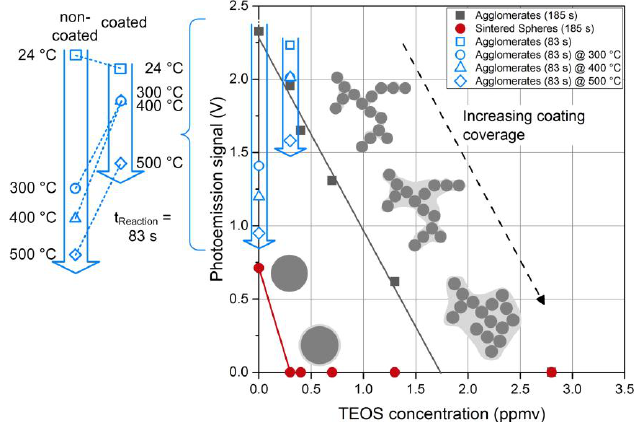
Figure 12. Measurement of the coating coverage by photoemission for Pt particles and sketches of the different kinds of observed coatings from TEM micrographs ( t Reaction = 185 s). Additionally, the open, blue symbols show the change in APE signal depending on the sintering temperature, analogous to the particles shown in Figure 13 ( t Reaction = 83